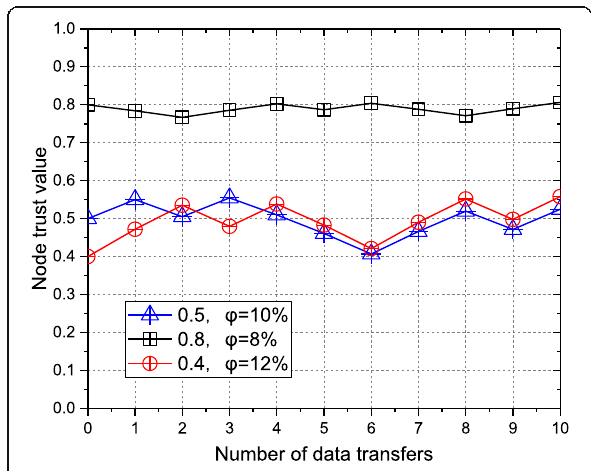
Fig. 8 Change of trust value if verification is random